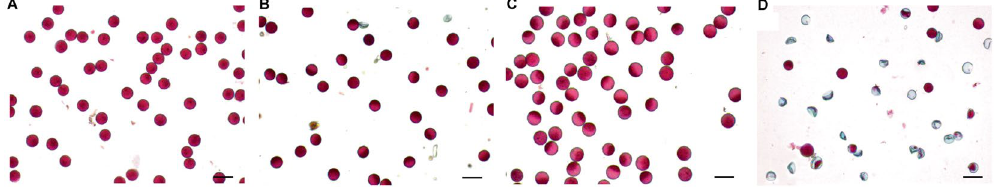
Figure 4. Alexander’s staining of anthers at stage 12. Pollen grains in wild-type (WT) ( A ) the phyA mutant ( B ) and the phyB mutant ( C ) are stained purple, indicating they are well developed. Most of the pollen grains in the phyA phyB mutant are stained green ( D ), indicating they were aborted. Bars = 50 µ m.